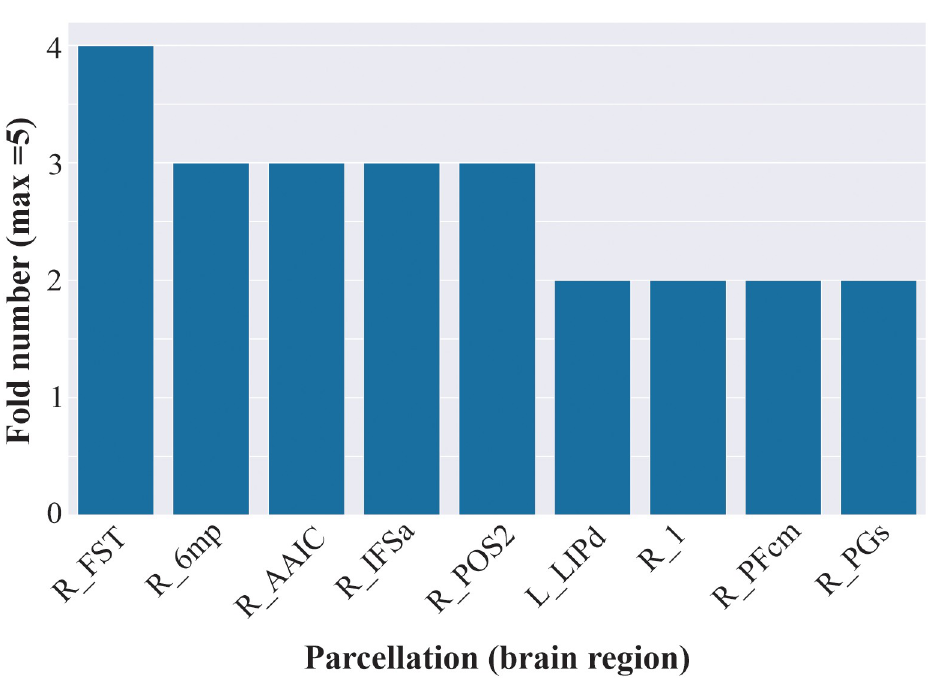
Fig 6. Count of recurring features across folds. By performing a count of feature appearance during the cross validation process, we determined that the same features (parcellations) responsible for positive class classification were also consistently used in 2 (R_PGs, R_PFcm, R_1, L_LIPd), 3 (R_POS2, R_IFSa, R_AAIC, R_6mp), or 4 (R_FST) out of the 5 folds, suggesting that these same features were regularly used throughout the decision making process. Note that this plot was abbreviated to only show features with a count of greater than